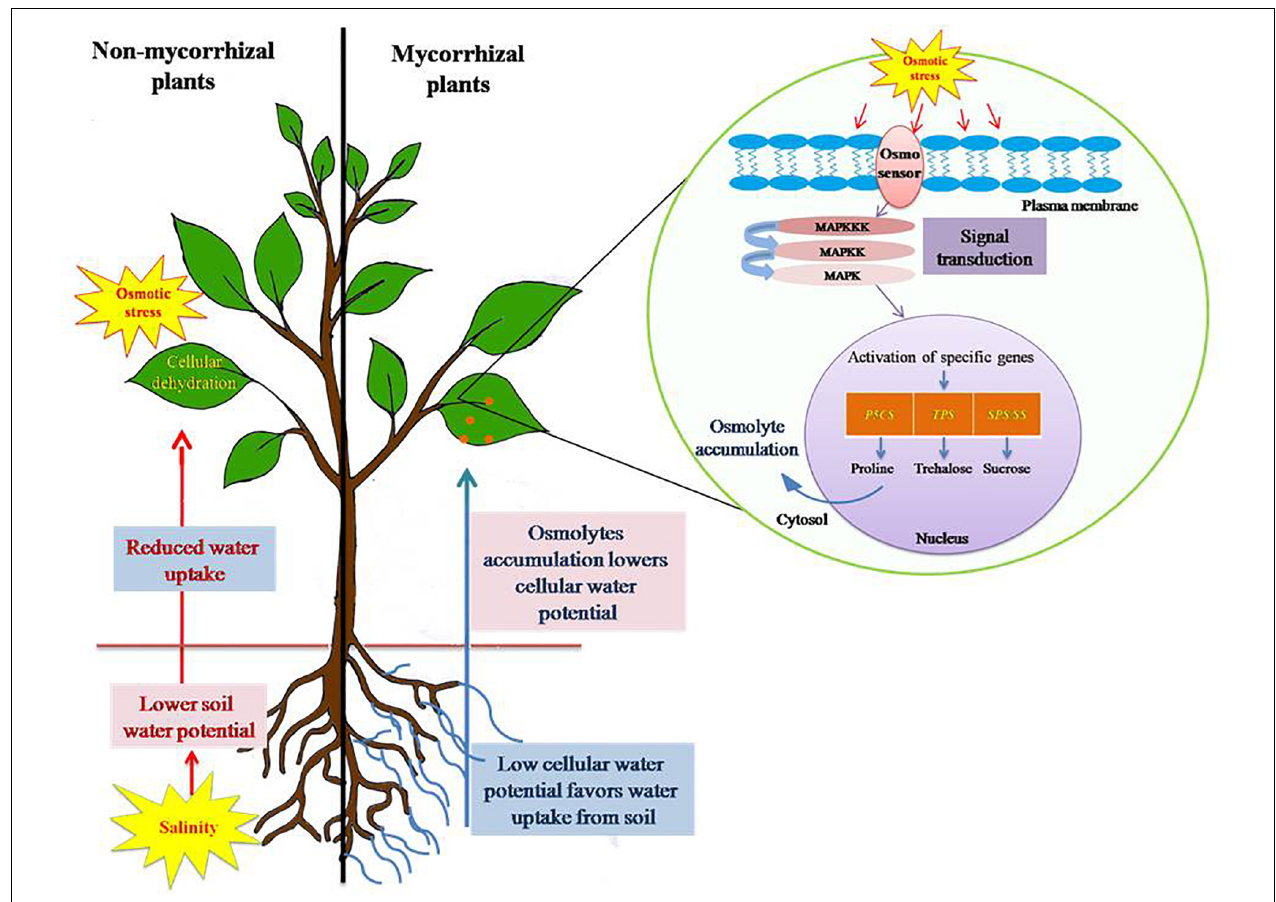
FIGURE 3 | Salinity stress induced osmotic stress tolerance mechanism in plants. Salinity leads to build up of Na + and Cl - in soil, consequently lowering the soil water potential as compared to water potential of plant cells. This leads to reduced water uptake by plants and eventually causes cellular dehydration. Plants, in order to avoid such consequences, accumulate osmolytes, such as proline, trehalose, polyamines, and sucrose in higher concentration. Osmolytes accumulation results in lowering of cellular water potential and thereby maintains a favorable gradient for water uptake from soil to root. Thus, it prevents cellular dehydration and subside osmotic stress caused by salinity. AM symbiosis alleviates osmotic stress by influencing the expression of specific genes ( P5CS , pyrroline-5-carboxylate synthase; TPS, trehalose-6-phosphate synthase; SPS , sucrose phosphate synthase; SS , sucrose synthase) involved in the biosynthesis of